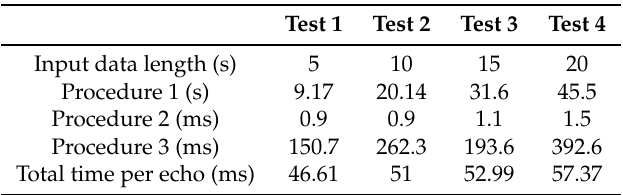
Table 7. Time profiling of Procedure 1 for wavelet-based filtering, Procedure 2 for body movement compensation and Procedure 3 for variational nonlinear chirp mode decomposition based estimation in Heartbeat Estimation And Recovery approach.